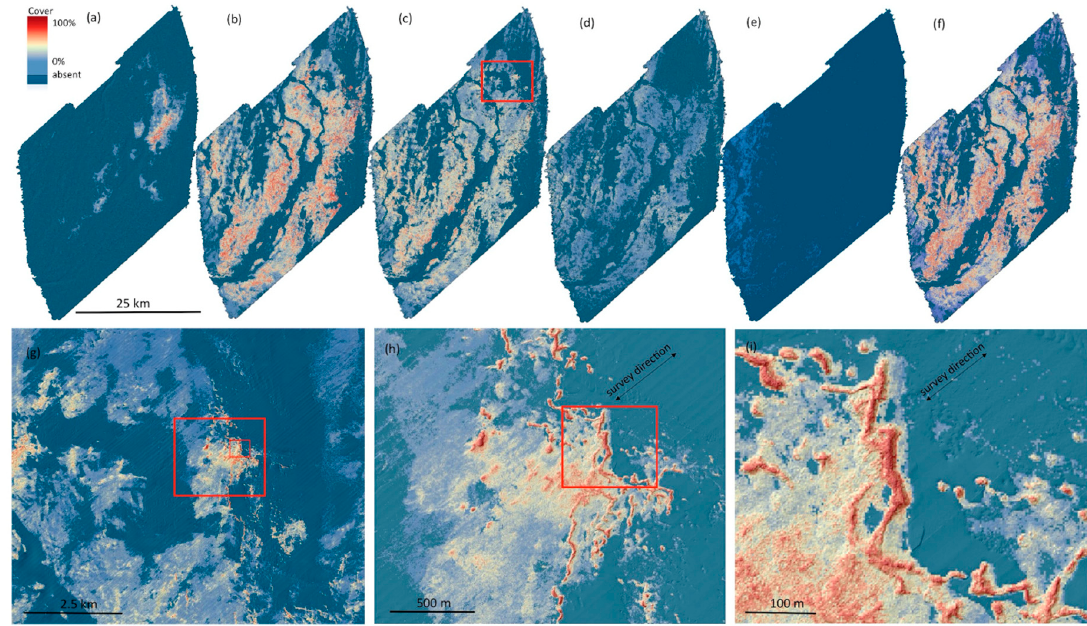
Figure 7. Percent coverage of HUB level-5 groups. ( a ) Annual algae, ( b ) perennial algae, ( c ) epibenthic bivalves ( Mytilus spp.), ( d ) cnidarians, ( e ) epibenthic moss animals ( Bryozoans ), ( f ) colonized substrate, ( g ) Mytilus spp. with hillshade 5 m zoom level 1, ( h ) Mytilus spp. with hillshade 1 m zoom level 2, ( i ) Mytilus spp. with hillshade 1 m zoom level 3. Absence is based on modeled threshold (<0.01% cover).